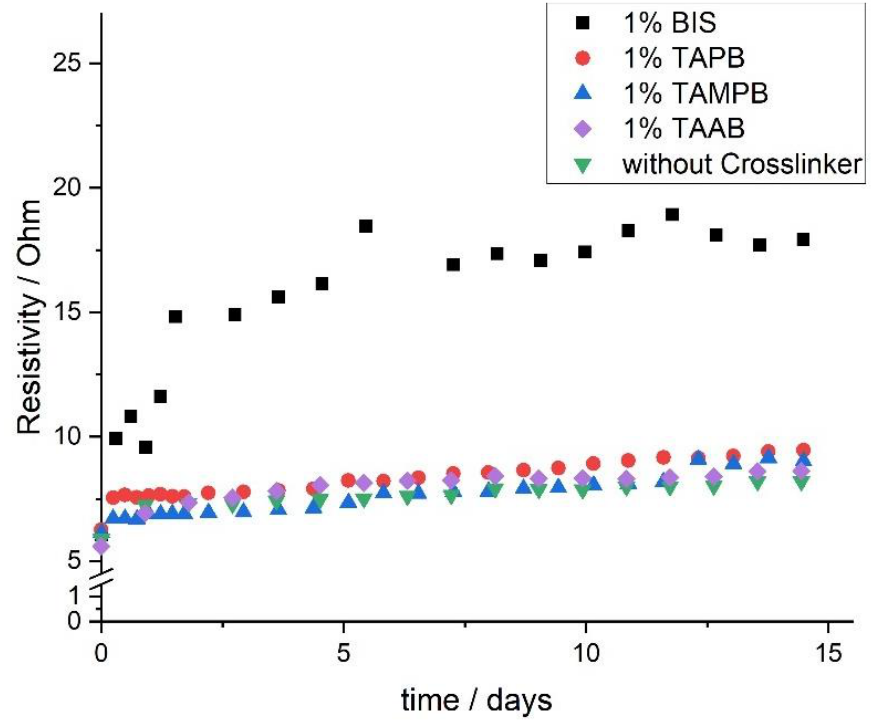
Figure 6. Evolution of the solution resistance Z real of pure poly(DADMAC) ( (cid:72) ) and gels cross-linked with 1 mol% BIS, TAAB ( 1a ), TAPB ( 1b ), or TAMPB ( 1c ) over the course of 14 days.